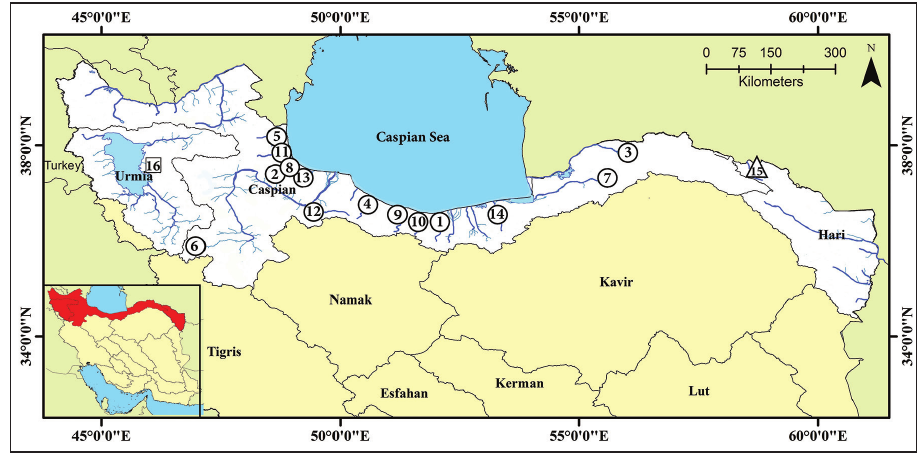
Figure 1. Map of the southern Caspian Sea basin and sampling points. Numbers of the sampling sites correspond to the numbers of sampling sites in Table 1, circle: Capoeta razii sp. n., triangle: C. fusca , square: C. Table 1. Sampling sites and coordinates. Numbers in the first column (Loc) correspond to numbers on the sampling map in Figure 1. Loc.